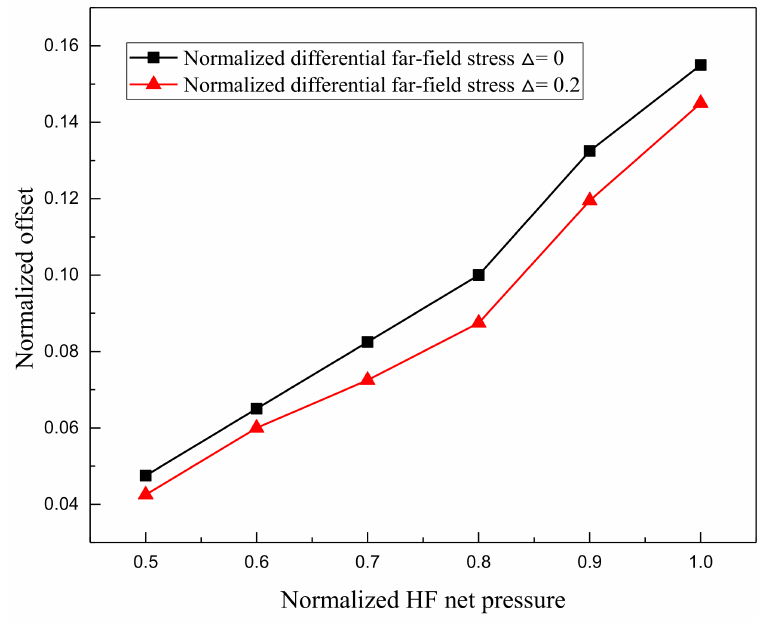
Figure 14. Offsets of the maximum principal stresses as a function of hydraulic fracture (HF) net pressure.